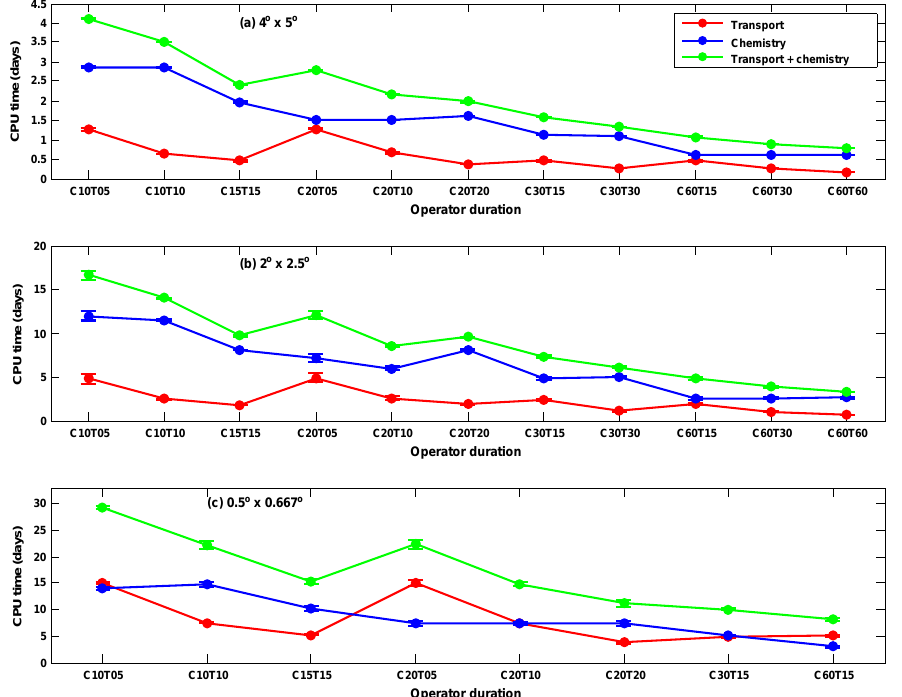
Figure 1. CPU time for GEOS-Chem simulations with various operator durations at three horizontal resolutions. Global simulations are at 4 ◦ × 5 ◦ (a) and 2 ◦ × 2.5 ◦ (b) resolutions. Panel (c) contains results for the average of two nested regions North America and East Asia at 0.5 ◦ × 0.667 ◦ resolution. Colored lines represent the CPU time for simulating transport (red) and chemical (blue) operators, and the sum of the two (green). Error bars represent standard error over five simulations. Simulations are represented in the abscissa as CccT tt with chemical operator duration, C = cc min, and transport operator duration, T = tt